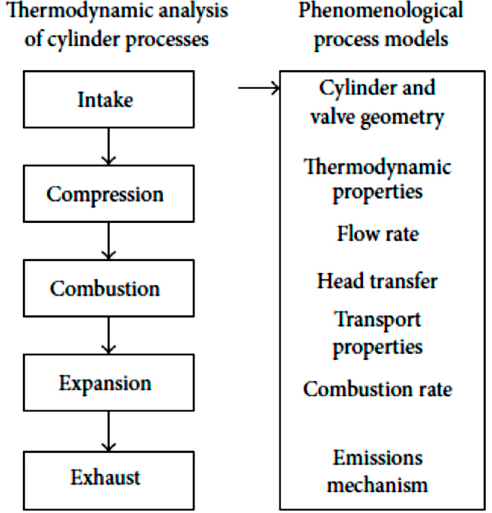
Figure 2. Structure of thermodynamic based simulation of ICE operating cycle reproduced from [14], with permission from Hindawi Publishing Corporation, 2020.